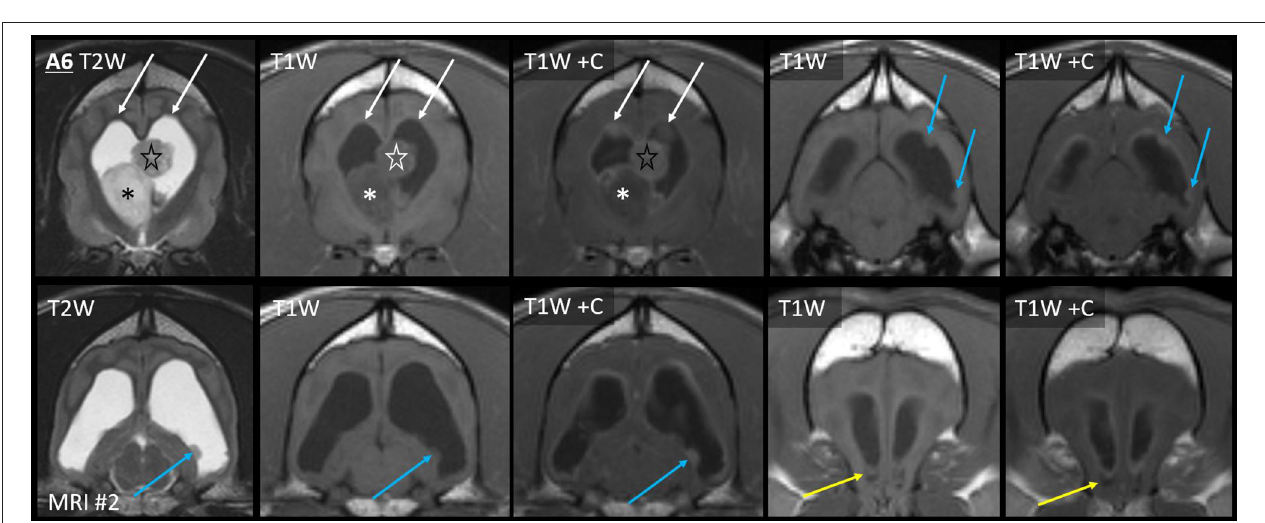
FIGURE 10 | Myriad type II ependymal lesions, Case A6. Transverse images from MRI #2 (level of the interventricular foramina, which have been effaced; level of the occipital lobes; level of the aqueduct; and the level of the rostral horns). The previously diagnosed primary mass is evident (asterisk). There are now metastatic ependymal nodules in both lateral ventricles, including the septum pellucidum (star) and five others (white and blue arrows). On T2W and T1W pre-contrast images, the dorsal parietal nodules are not visible (white arrows), whereas the other ependymal nodules are evident (blue arrows). There is also widespread, irregular ependymal contrast-enhancement (all post-contrast images). Yellow arrows highlight ventral rostral horn subependymal